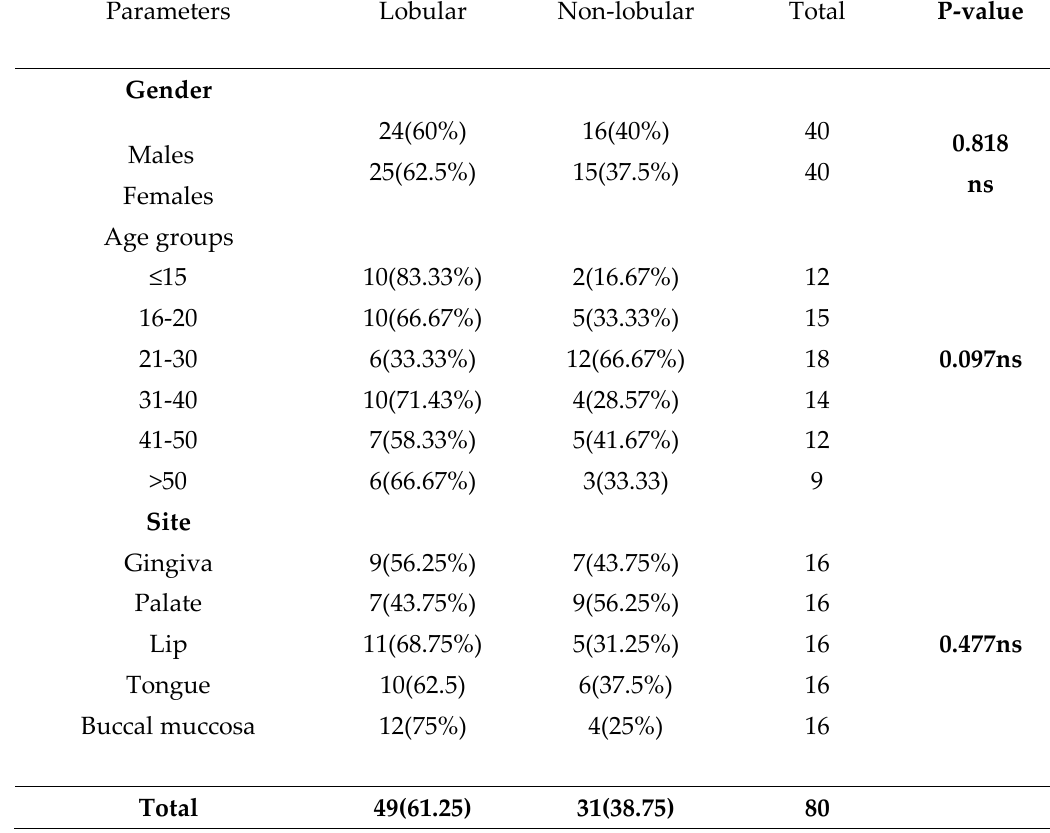
Table (1): Demographic description of studied cases (lobular and non-lobular pyogenic granulomas)concerining gender,age,and intraoral sites